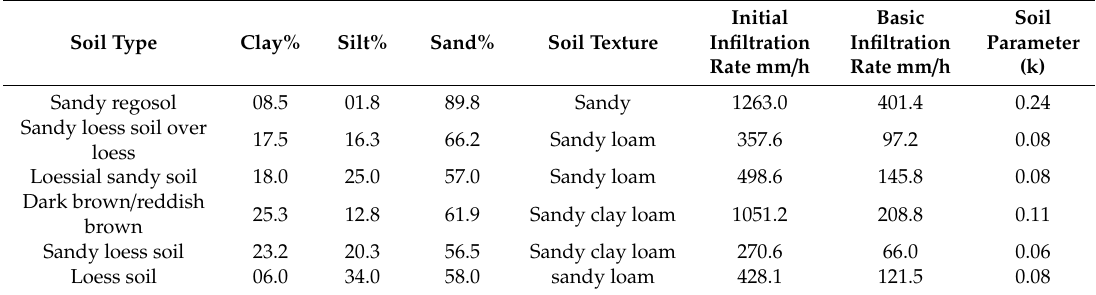
Table 1. Texture and infiltration parameters of the di ff erent soil types in the Gaza Strip